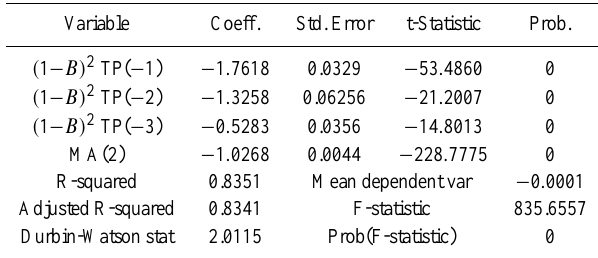
Figure16. Dominant wave period Tp partial auto correlation with 1hr time lag